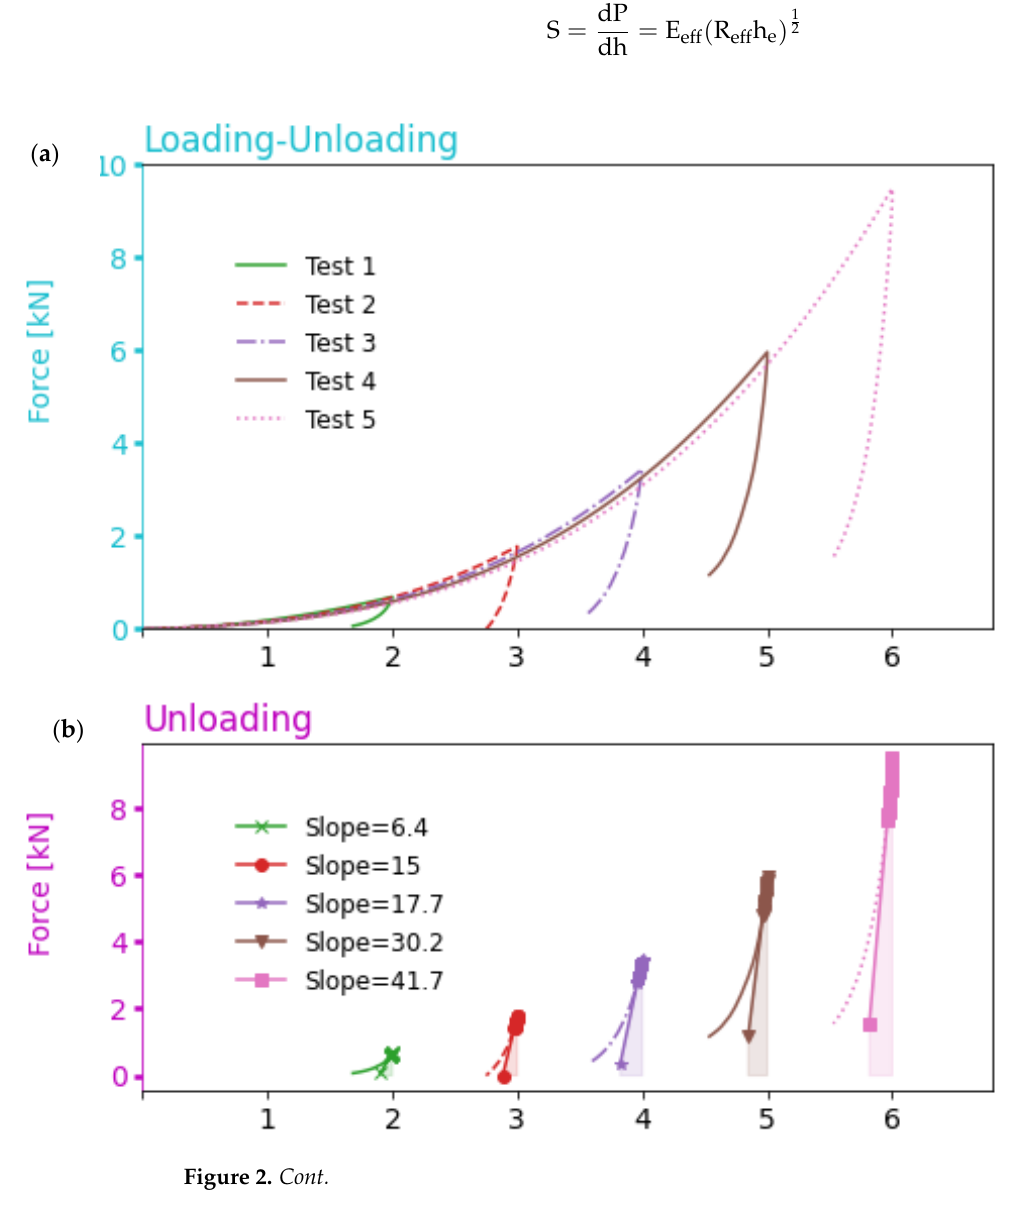
Figure 2. Five single-loading indentation tests at five different penetration depths ( a ), unloading segments ( b ), and degradation of Young’s modulus ( c ). 3.2. Analytical Approach to Convert Force-Depth into Stress-Strain Relation One of the challenges in the indentation test is determining the projected contact area between two crossed cylinders (the indenter and LIB cell). In this study, an analytical ap- proach was developed to calculate the projected contact area as a function of the indenter depth. As the experimental results show in Figure 3a, the deformed area has an elliptical shape. According to Hertz’s theory, Popov [54] proposed a model to measure the contact